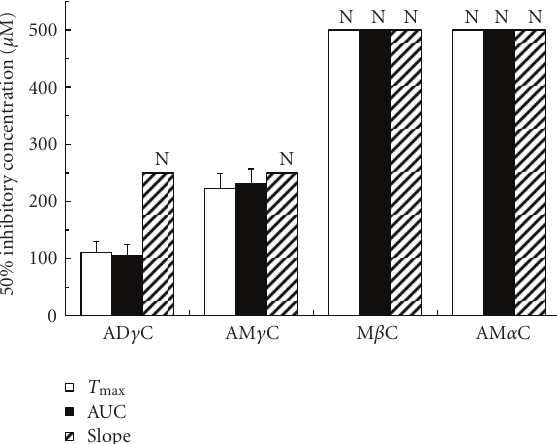
Figure 7: Concentrations of carbolines to produce 50% inhibition of the platelet aggregation responses ( T max , AUC, and slope) to thrombin. N: Not inhibited by 50% at the indicated concentrations. Data are presented as mean ± SE ( n = 7).